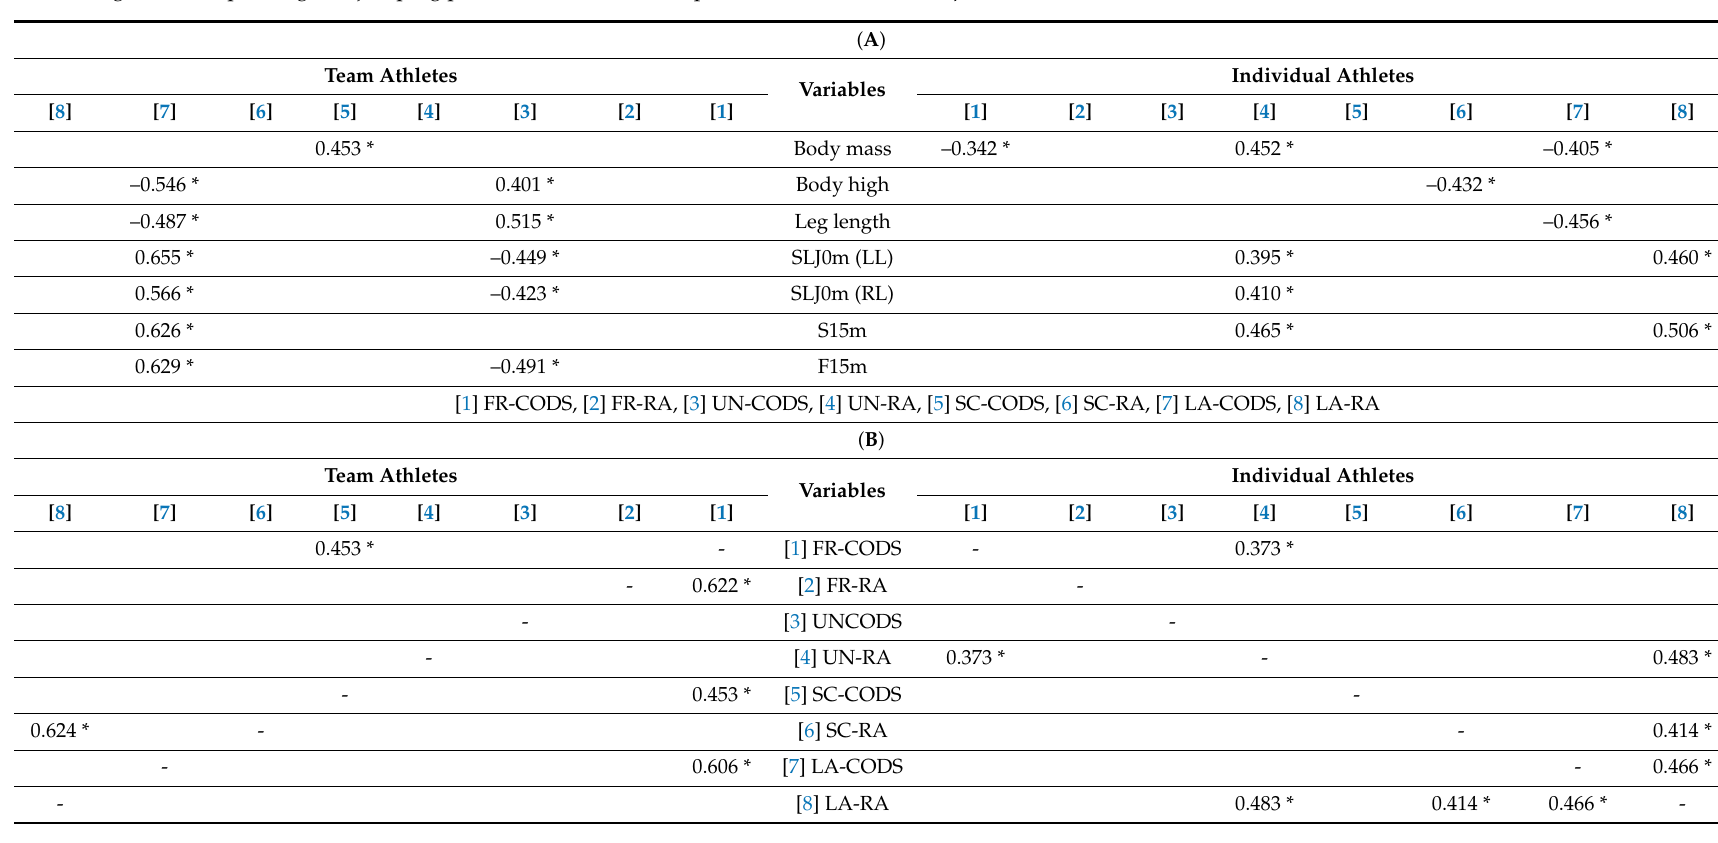
Table 6. Correlations between change-of-direction speed (CODS) and reactive agility (RA) in the frontal (FR), universal (UN), semi-circular (SC), and lateral (LA) configurations, sprinting and jumping performance, and anthropometric characteristics, * p <